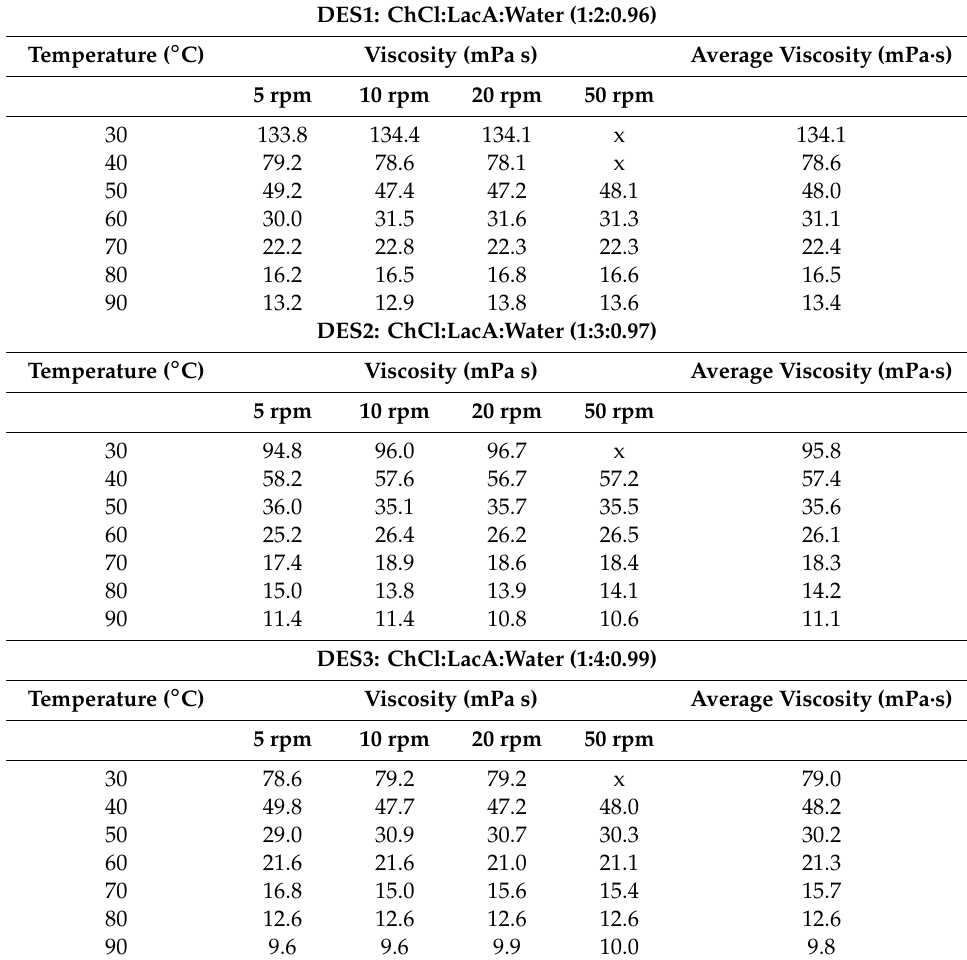
Table 4. Viscosity of the studied DESs for di ff erent temperatures and revolutions (5–50 rpm). DES1: ChCl:LacA:Water